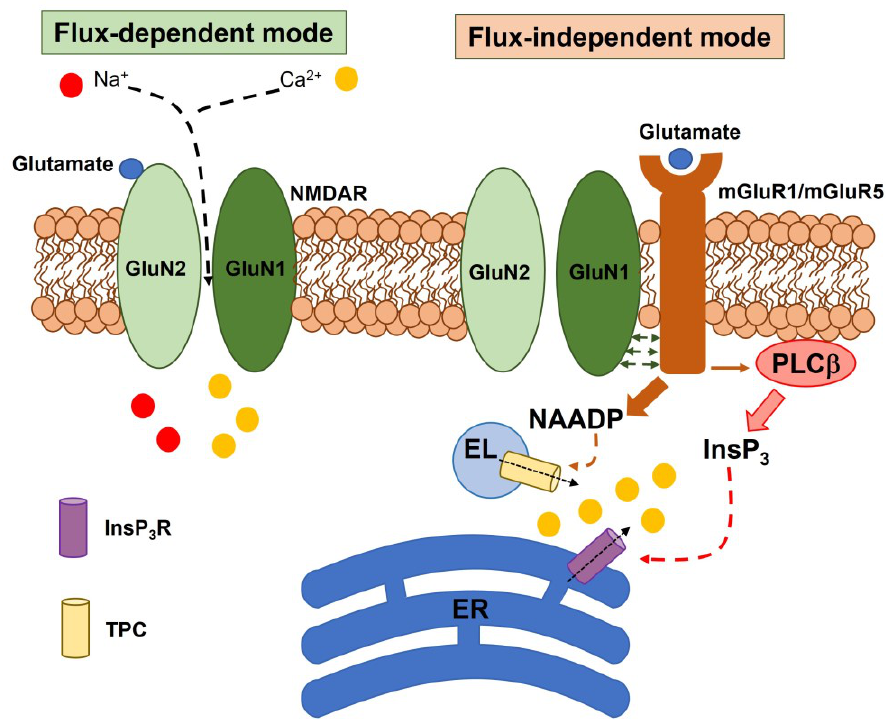
Figure 2. NMDARs may signal in a flux-independent mode to elicit intracellular Ca 2+ release. NMDARs can signal in either a flux-dependent or independent mode [24,27]. Ionotropic NMDARs mediate the influx of extracellular Na + and Ca 2+ and induce membrane depolarization or recruit Ca 2+ -dependent decoders such as nNOS (not shown). Metabotropic NMDARs can interact with mGluR1 and mGluR5 to stimulate PLC β and promote InsP 3 -induced ER Ca 2+ release. In addition, metabotropic NMDAR signaling involves the NAADP-induced mobilization of lysosomal Ca 2+ . The